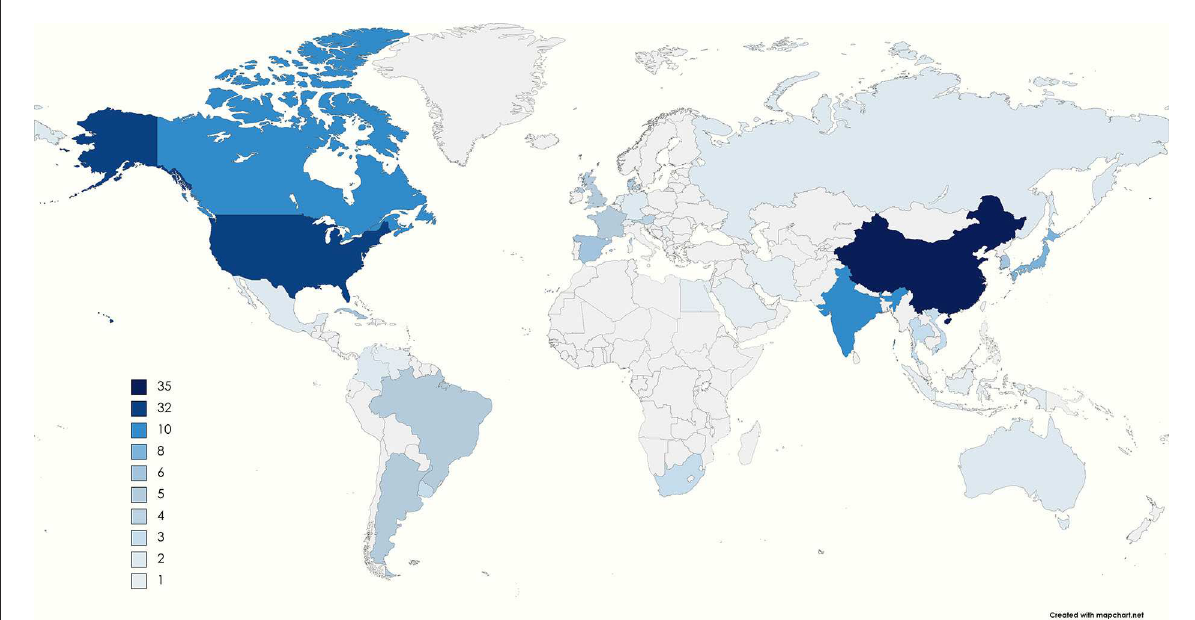
FIGURE2 The number of GMP manufacturing companies in each country (41–104). The color range goes from light blue to dark blue, and the gray sections indicate that no companies are governed under the GMP requirements. The legend shows the number of GMP manufacturers in